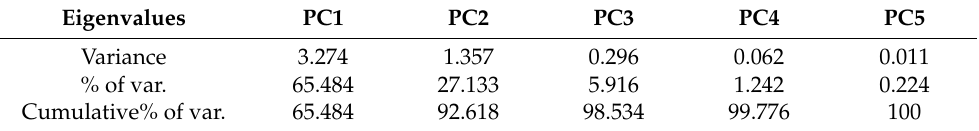
Table 7. The eigenvalues of the correlation matrix (20 m/s).